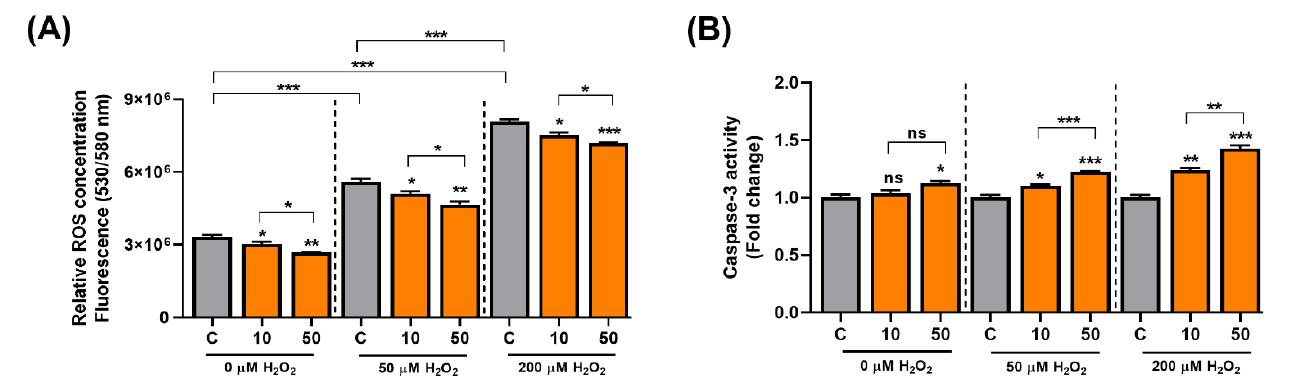
Figure 4. C3G modulates ROS and cell signaling in hepatocarcinoma cells. ( A ) ROS assay. ( B ) 3-caspase activity of HepG2 cells co-treated with 0, 50 and 200 µM H 2 O 2 . The results represent the mean ± SEM (n = 3). For comparisons between two groups, Student’s t -test was performed. *, p < 0.05; **, p < 0.01; ***, p < 0.005 compared with controls. C, control (0.1% DMSO); C3G, Cyanidin 3-glucoside; ns, not statistically significant.